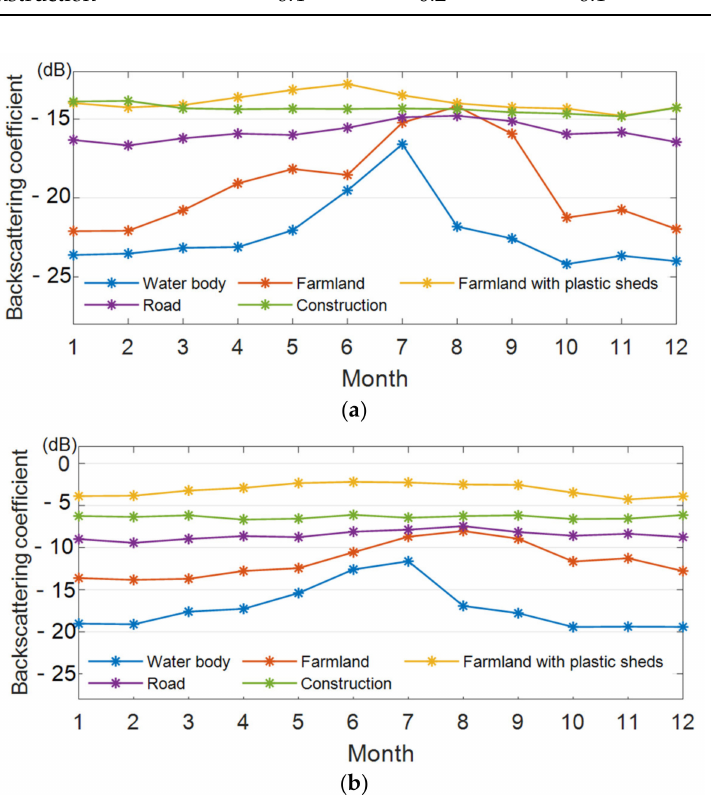
Figure 6. Line chart of monthly backscattering coefficient in 2019: ( a ) Backscattering coefficients with integrated orbit and VH polarization; ( b ) Backscattering coefficients with integrated orbit and VV